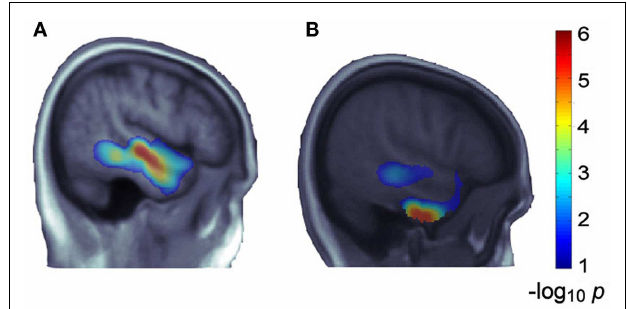
FIGURE 3 | MACROD2 ’s effects inADNI temporal lobes and partial replication in a younger cohort. The SNPs selected from MACROD2 in ADNI are strongly associated with mean temporal lobe volumes ( p = 7.94 × 10 − 12 ), and reveal extensive and significant effects onTBM maps of temporal lobes (A) .We studied the joint effect of the same group of SNPs in MACROD2 on temporal lobe maps of the Brisbane young adult dataset.The gene effect showed reproducibility, including effects at some specific locations overlapping with the ADNI findings, after correction for multiple comparisons across the temporal lobe voxels (B) . A sagittal slice from the left hemisphere is shown; warmer colors represent more significant associations. Both (A,B) are taken from the same slice ( x = 53mm in Montreal Neurological Institute coordinates).The slices do not appear identical due to the age range differences between the populations [e.g., atrophy in (A) ], but almost all of the significant voxels in the more central cluster in (B) overlap with the significant voxels in (A) , implying